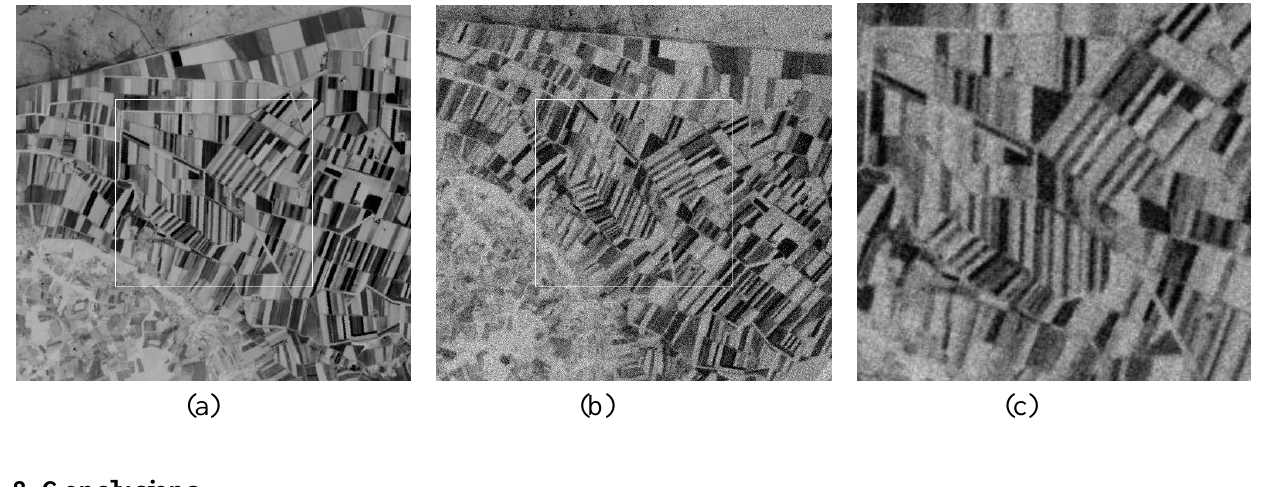
Figure 10. Registration of multi-temporal SPOT images: (a) the input image, (b) the sensed noisy image to be corrected, and (c) the registered image with the second proposed